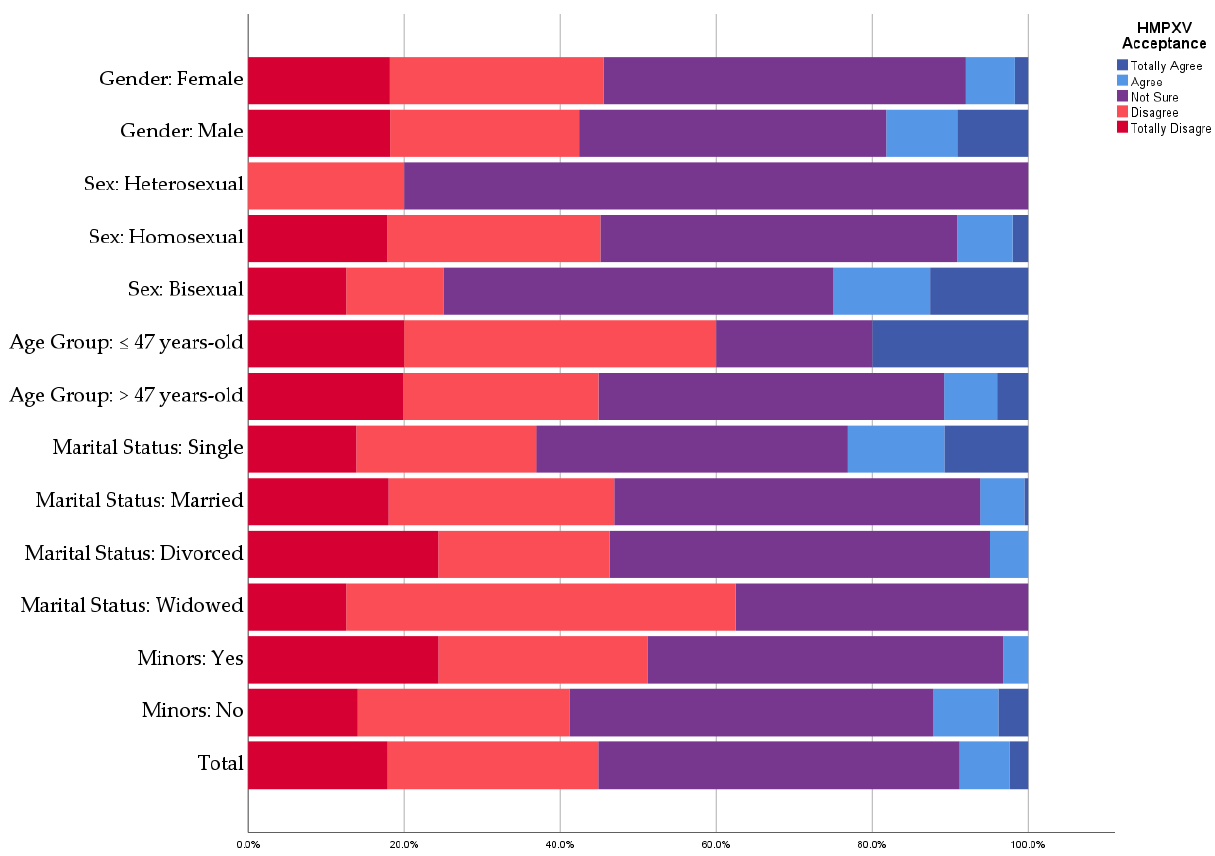
Figure 3. Demographic predictors of HMPXV vaccine acceptance among Czech HCWs, September 2022 ( n = 341).